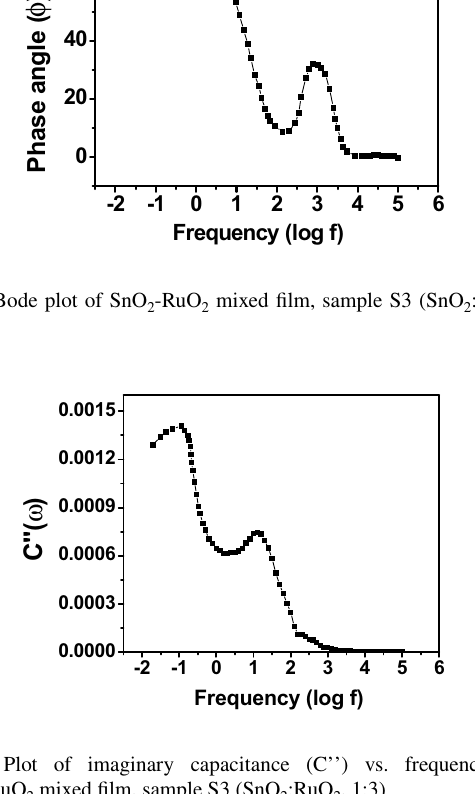
Fig. 10 Plot of imaginary capacitance (C’’) vs. frequency for SnO 2 -RuO 2 mixed film, sample S3 (SnO 2 :RuO 2 ,